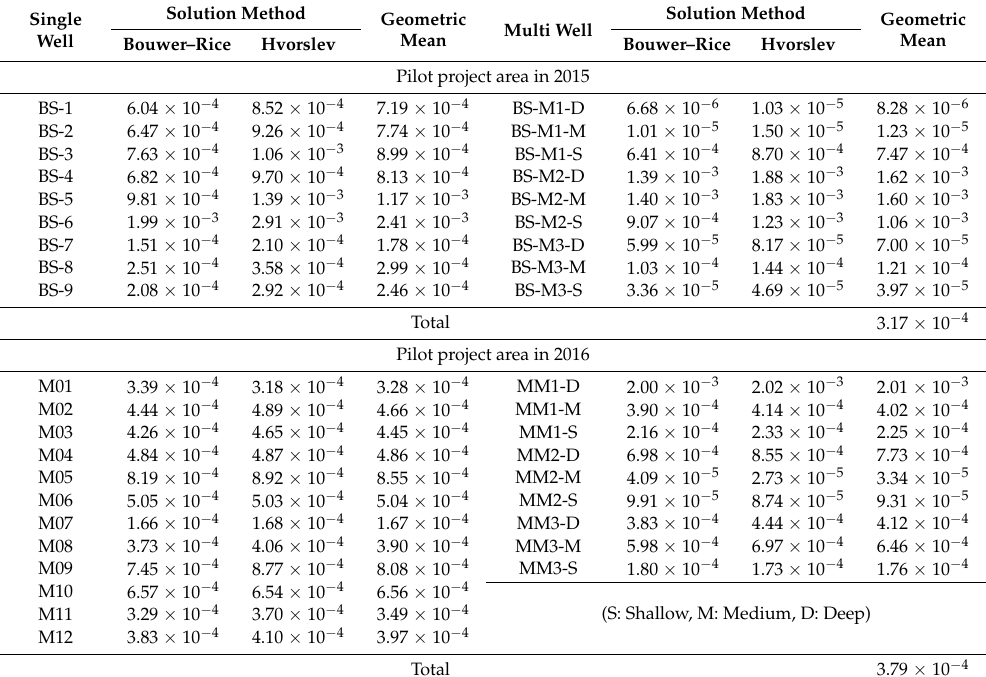
Table 13. Results of slug test at pilot project